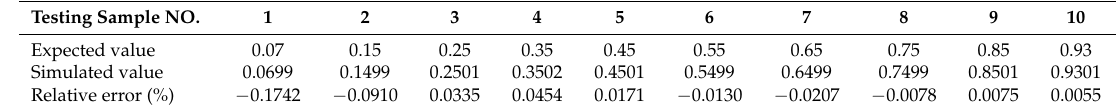
Table 3. Predicting results for testing dataset based on the developed LSSVM model. Testing Sample NO.